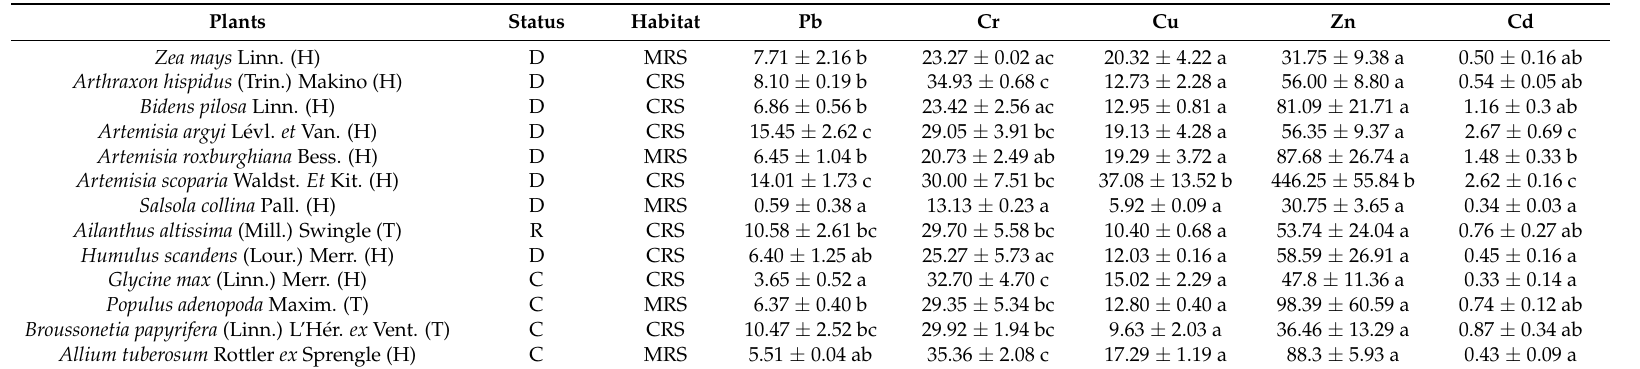
Table 3. Heavy metal concentrations of plant AG part (mg · kg − 1